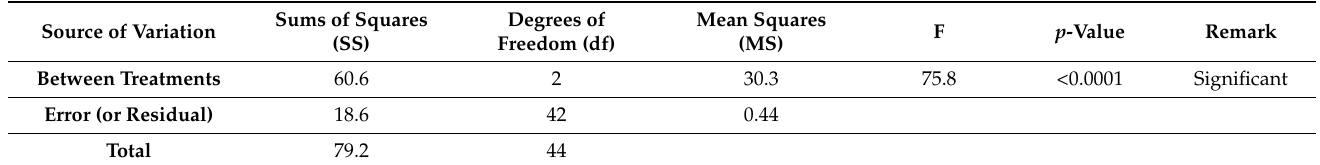
Table 5. Statistical Analysis Results for MOS Metric of HD Video.